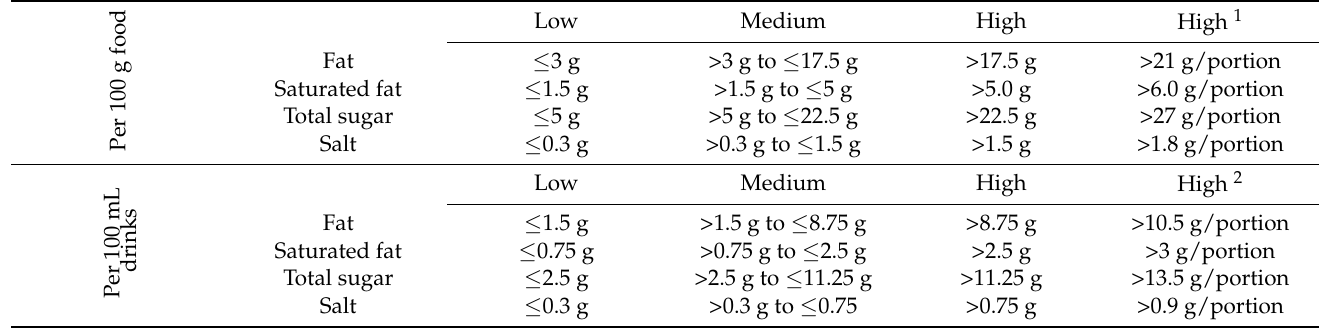
Table 1. FOPNL nutrient threshold cut-offs applied to the UAE, UK, US and